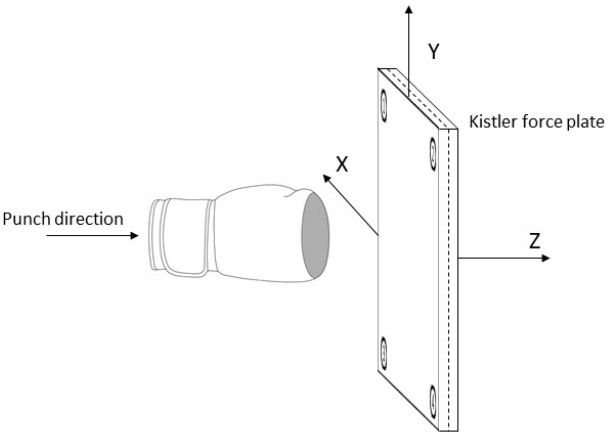
Figure 1. Test setup schematic .